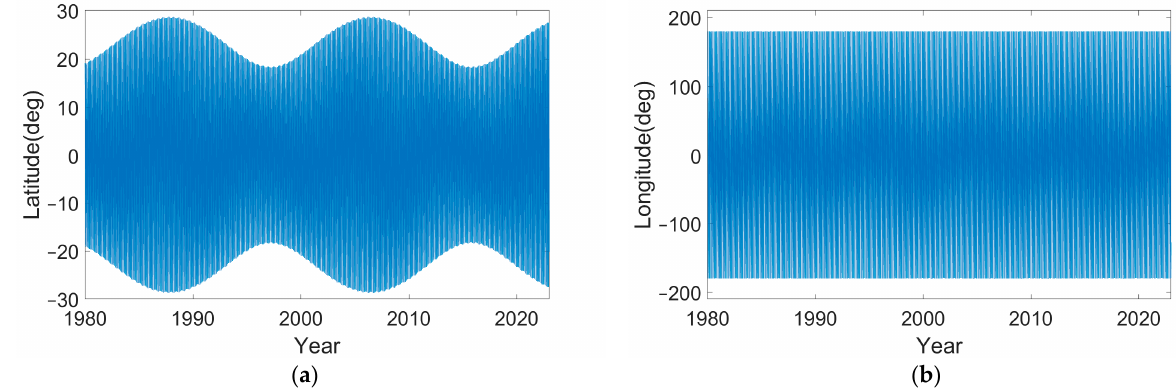
im θ Figure 5. Simpli fi ed MS-BiSAR Earth observation geometrical model. 𝑂 (cid:3040)(cid:3029)(cid:3042) is the Moon-based ob- servatory, 𝑂 (cid:3040) is the selenocenter, 𝑂 (cid:3006) is the geocenter, and 𝑂 (cid:3046) is the satellite. 𝜃 (cid:3036)(cid:3040) and 𝜃 (cid:3036)(cid:3046) are the threshold for the incidence angle of transmi tt er and receiver, respectively. 𝑆 (cid:2869) and 𝑆 (cid:2870) are the boundaries of the observable area of the satellite receiver. Meanwhile, 𝑀 (cid:2869) and 𝑀 (cid:2870) are the bound- aries of the observable area of the Moon-based observatory. The red area is de fi ned as the observable area of MS-BiSAR (not to scale for the sake of clarity). Based on the simpli fi ed MS-BiSAR Earth observation geometric model, we can derive several parameters, such as the nadir position and local incidence angle, for further analysis. 3.2. Nadir Points of the Moon-Based Observatory and Satellites on Earth The nadir point is the point on the Earth’s surface directly beneath a satellite or ce- lestial body at a given moment in time, while the nadir track refers to the path it follows as it orbits the Earth. By analyzing the nadir points and tracks, we can determine the rel- ative position and a tt itude between the Moon-based observatory, the satellite, and the Earth, allowing for further analysis of the observation characteristics of di ff erent bistatic con fi gurations for Earth observation. Since the distance between the Moon and the Earth is signi fi cantly larger than the radius of the Moon, the di ff erence between the nadir point of the Moon-based observatory and the Moon itself is negligible. Therefore, in this section, we refer to the nadir point of